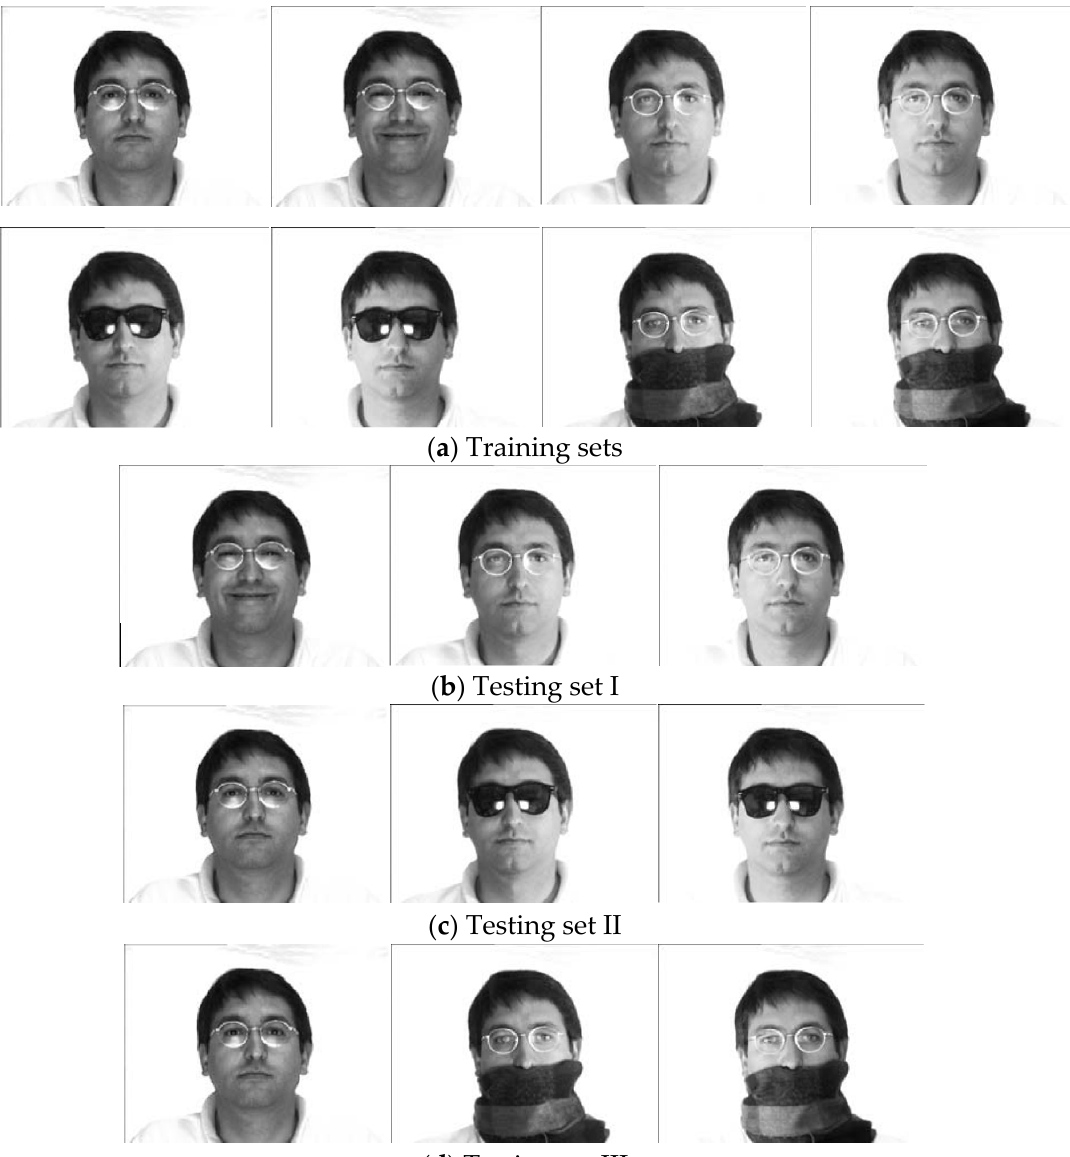
Figure 6. Some examples of the AR database. Eight face images per person were selected as training samples, one of which was not occluded and had no illumination change. Seven of them contained occlusion or illumination factors, as shown in ( a ). Testing set I is composed of 300 face images with normal light, strong light on the left, and strong light on the right, as shown in ( b ); testing set II is composed of 300 face images with sunglasses occlusion mixed with normal light, strong light on the left, and strong light on the right, as shown in ( c ); testing set III is composed of 300 face images with scarf enclosures that contain normal light, light on the left, and strong light on the left, as shown in ( d ). Table 5. Average Recognition Rate (%) on AR